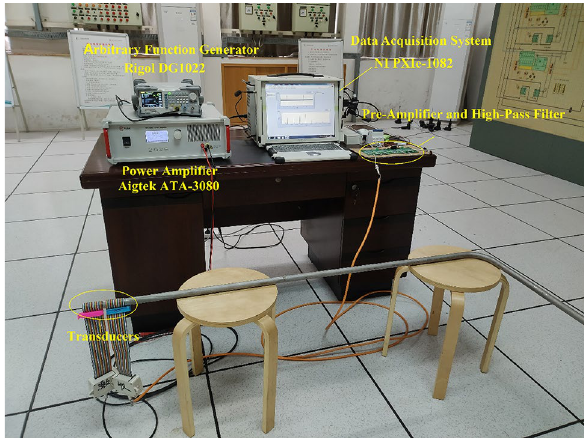
Figure 9. Experimental rig.